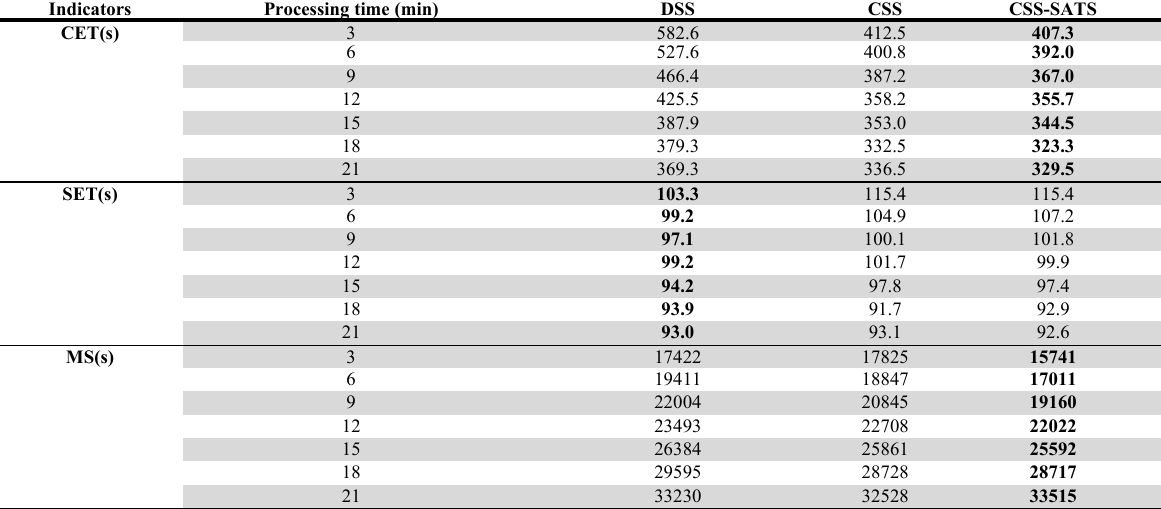
Result s of experiment C (The bold is the best value among three algorithms) (Continued) Indicators